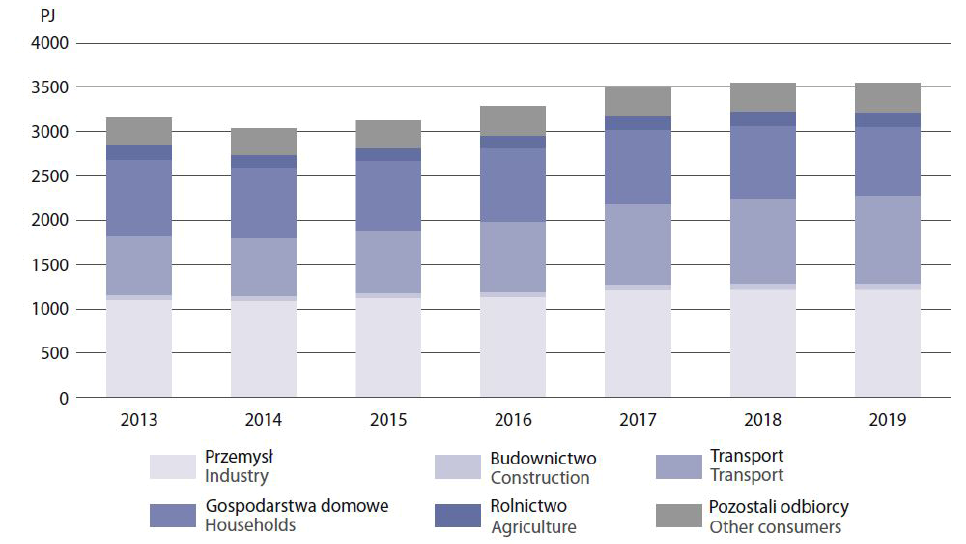
Figure 2. Poland’s energy consumption by sectors [17].